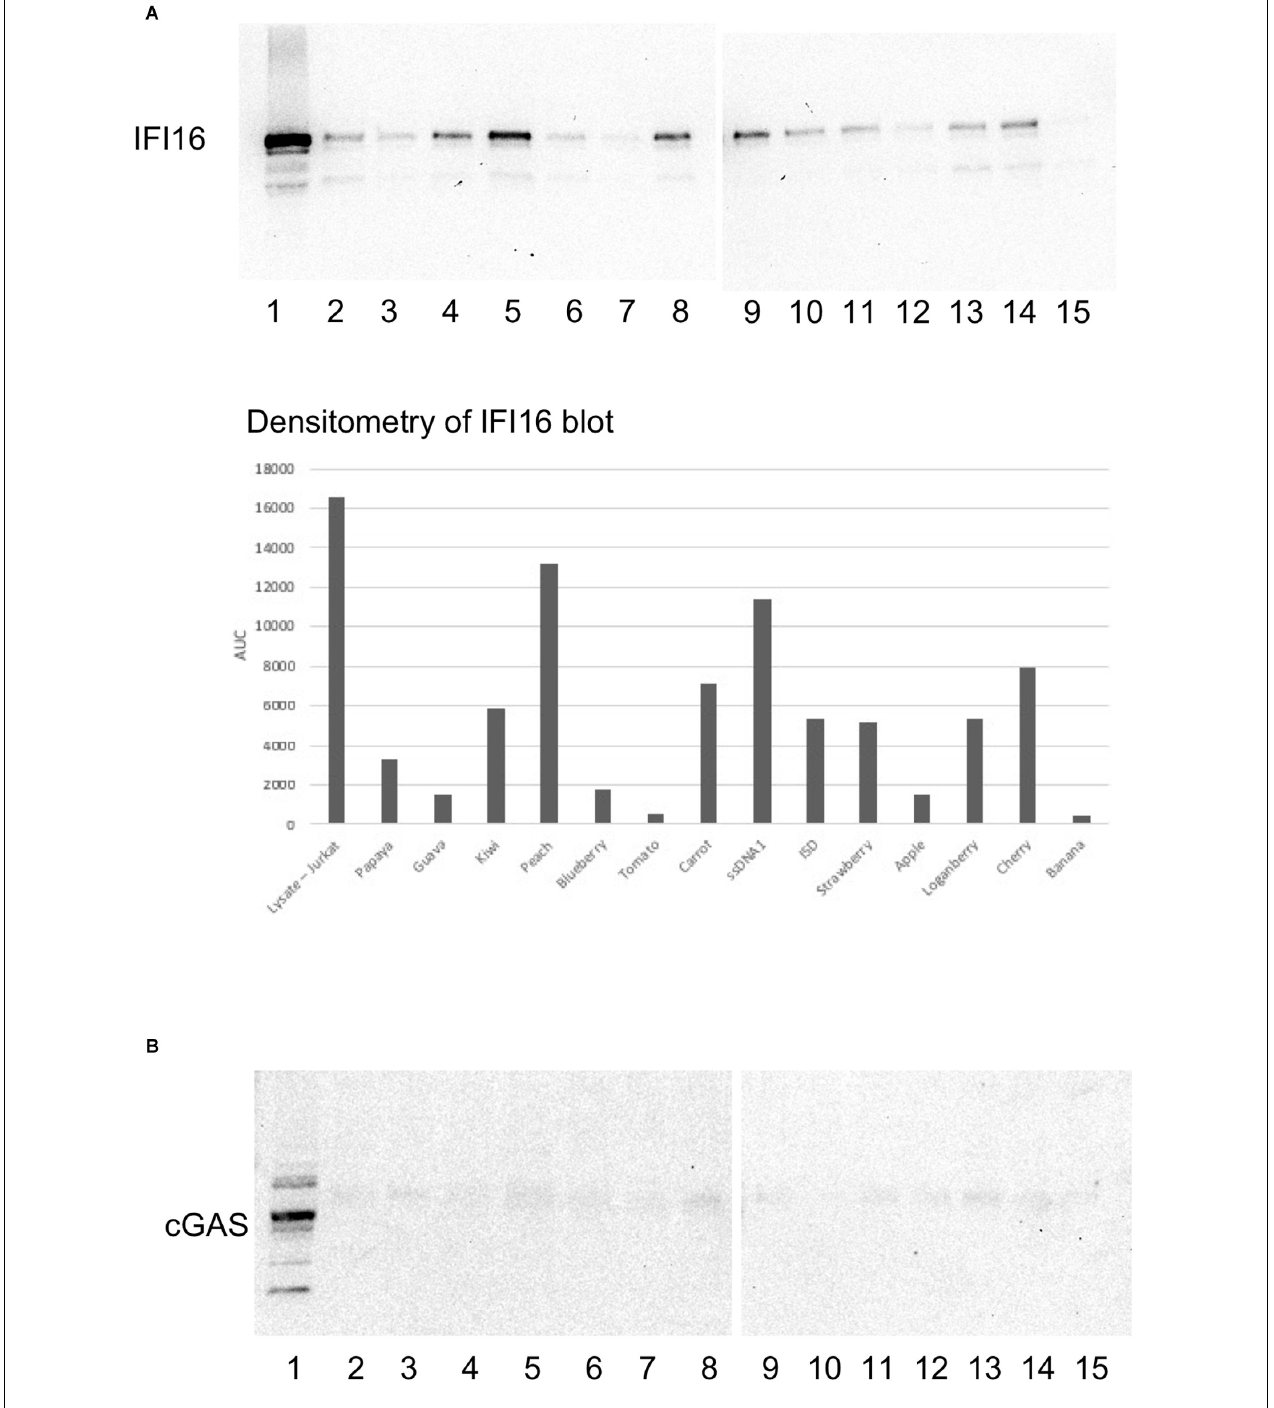
FIGURE 3 | IFI16 binds to HERV-K oligos with variable affinity. Oligo sequences spanning the HK2 genome were synthesized and biotinylated. Pre-cleared Jurkat cell lysates were incubated with the biotinylated oligos, as described in the section “Materials and Methods.” The pulldowns were analyzed by SDS-PAGE and western blotting first for IFI16 (A) , followed by reprobing the same blot for cGAS (B) . The lysates or oligos in each lane are: (1) lysate (2) Papaya (3) Guava (4) Kiwi (5) Peach (6) Blueberry (7) Tomato (8) Carrot (9) HIV-1 ssDNA1 (10) ISD (11) Strawberry (12) Apple (13) Loganberry (14) Cherry (15) Banana. For oligo sequences, see Figure 1 . ISD, the immunostimulatory domain from Listeria (Hansen et al., 2014). Densitometry was performed on the IFI16 blots by measuring the area under the curve (AUC) with Image J.